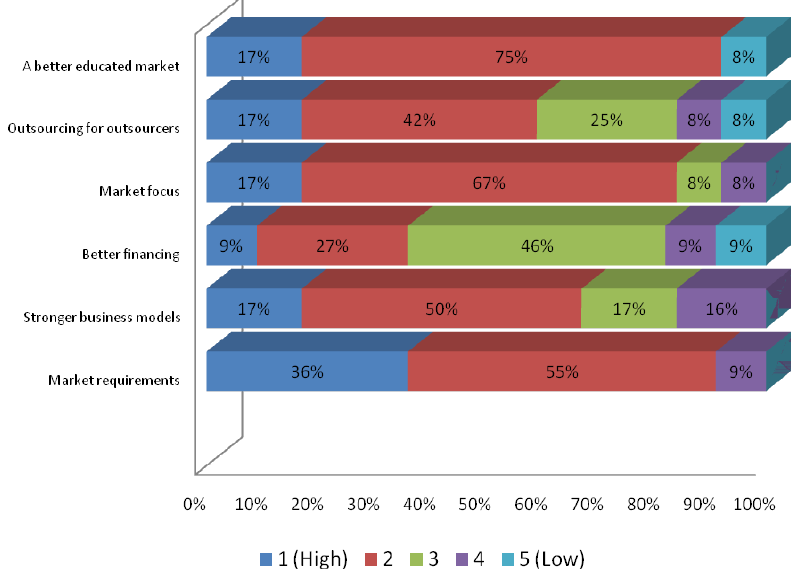
Figure 2 The cloud advancements on the mistakes made by the Dot.com bubble (Sourced from, Wohl